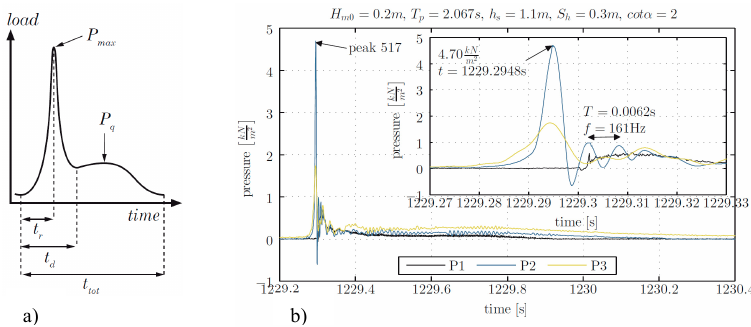
Figure 5. ( a ) Parameter definition describing a pressure impact event and ( b ) exemplary time series of the maximum impact event during test 204 for pressure sensors P1 , P2 and P3.